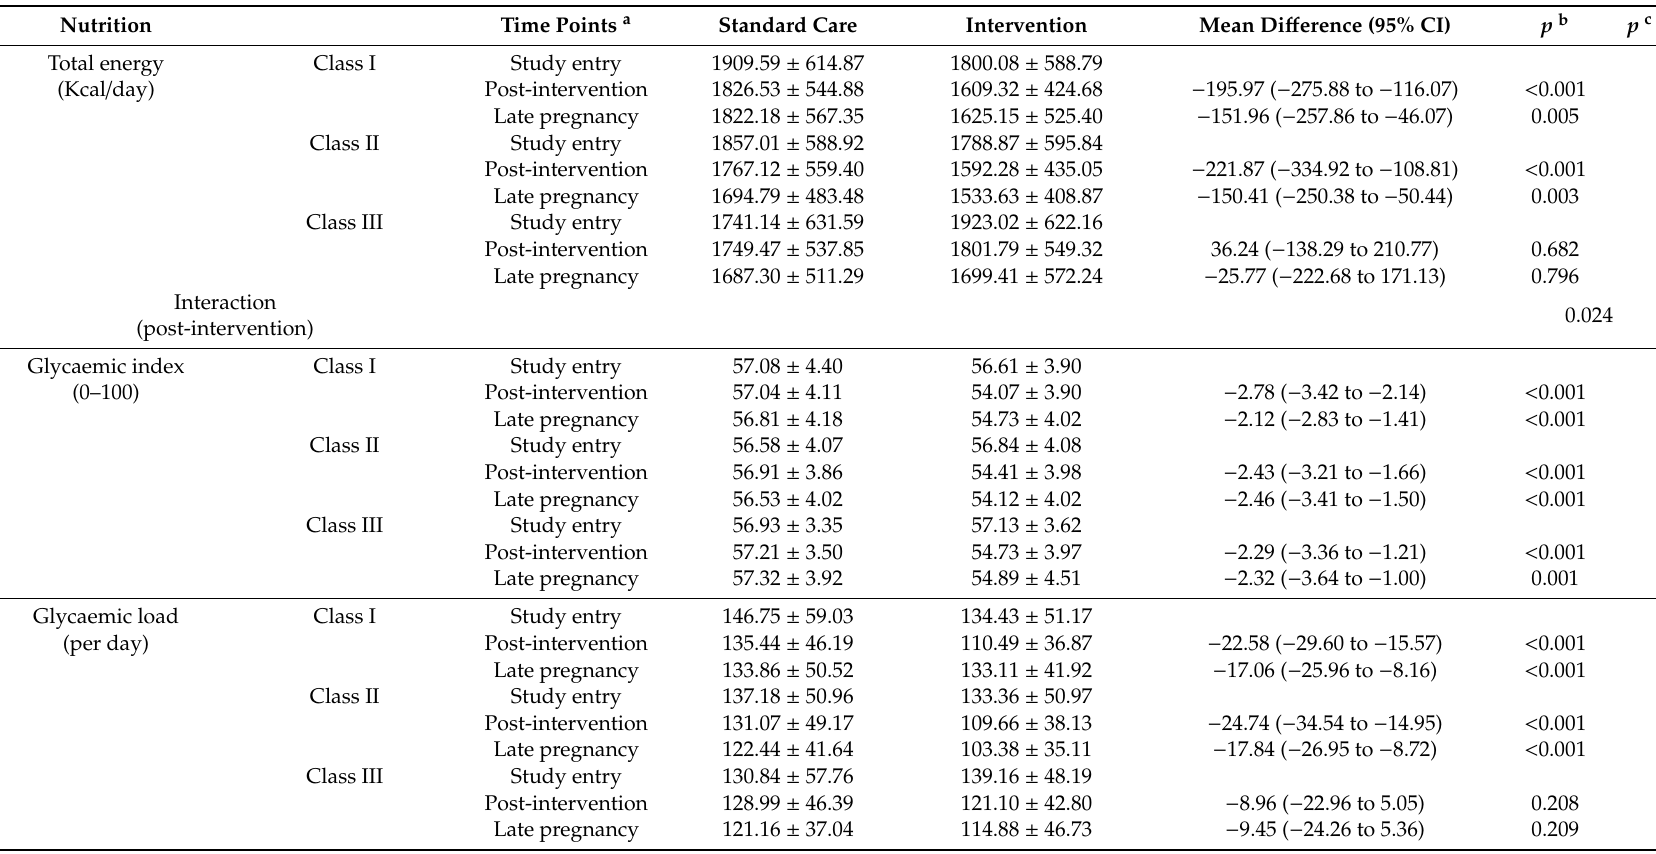
Table 2. Dietary Responses and Physical Activity at study entry, post-intervention and in late gestation, by intervention group and obesity class.